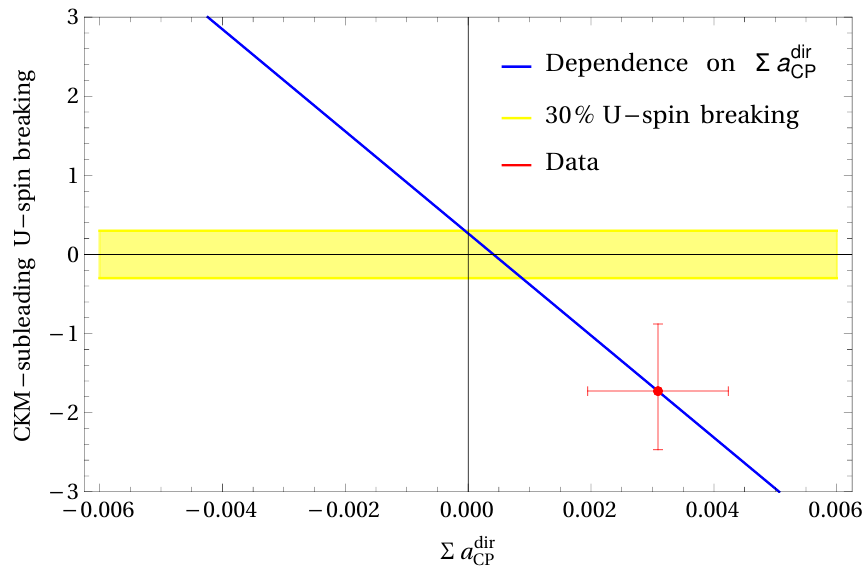
according to eq. (4.10). CP away from its CP and the resulting CP ) / Im(˜ p ) | ≈ 1 0